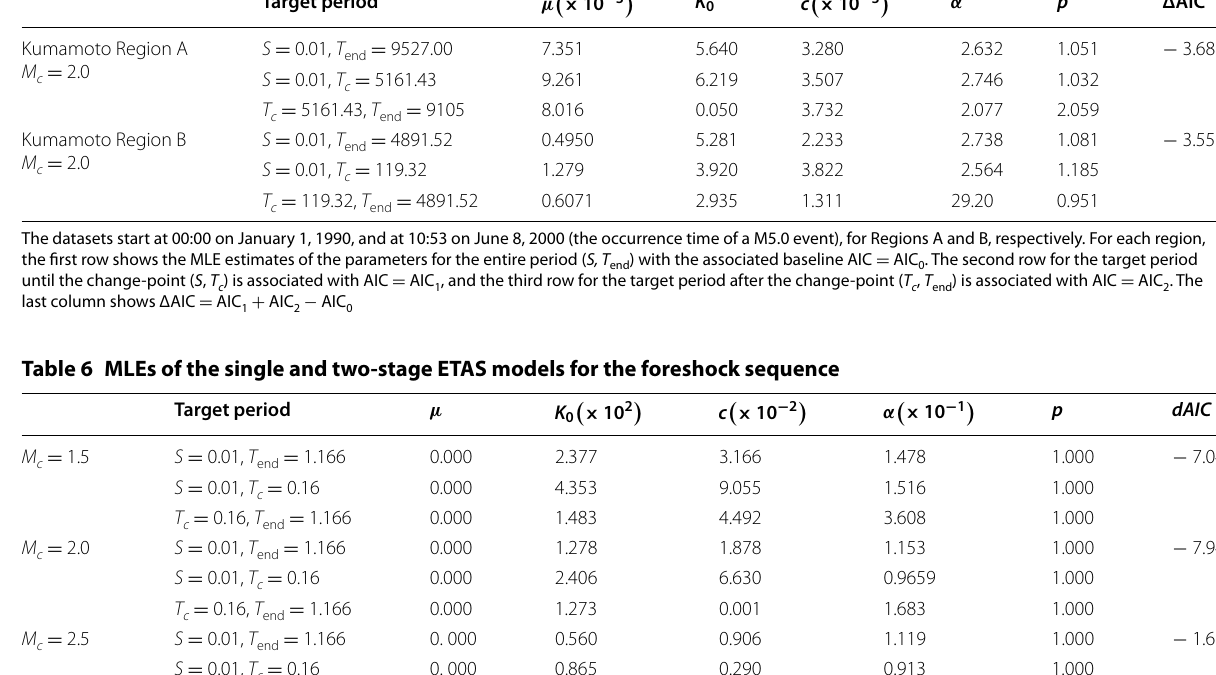
Table 5 The MLEs of the single and two-stage ETAS models estimated for Regions A and B in Fig. 4